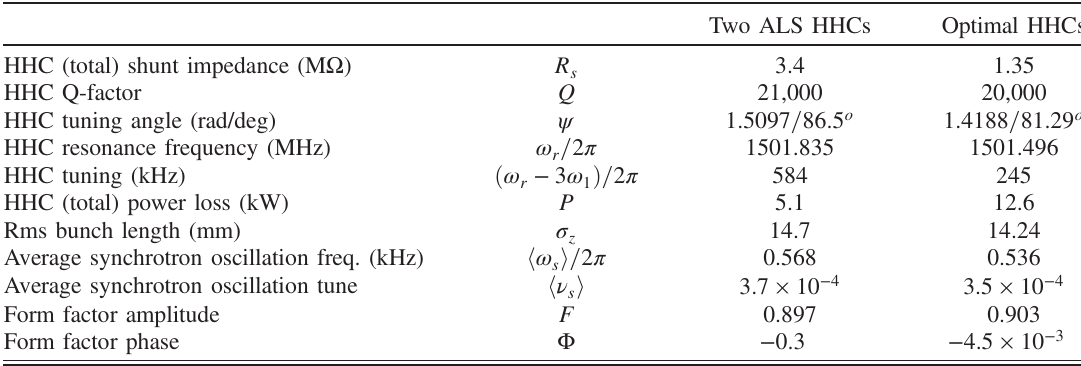
TABLE II. HHC design options and